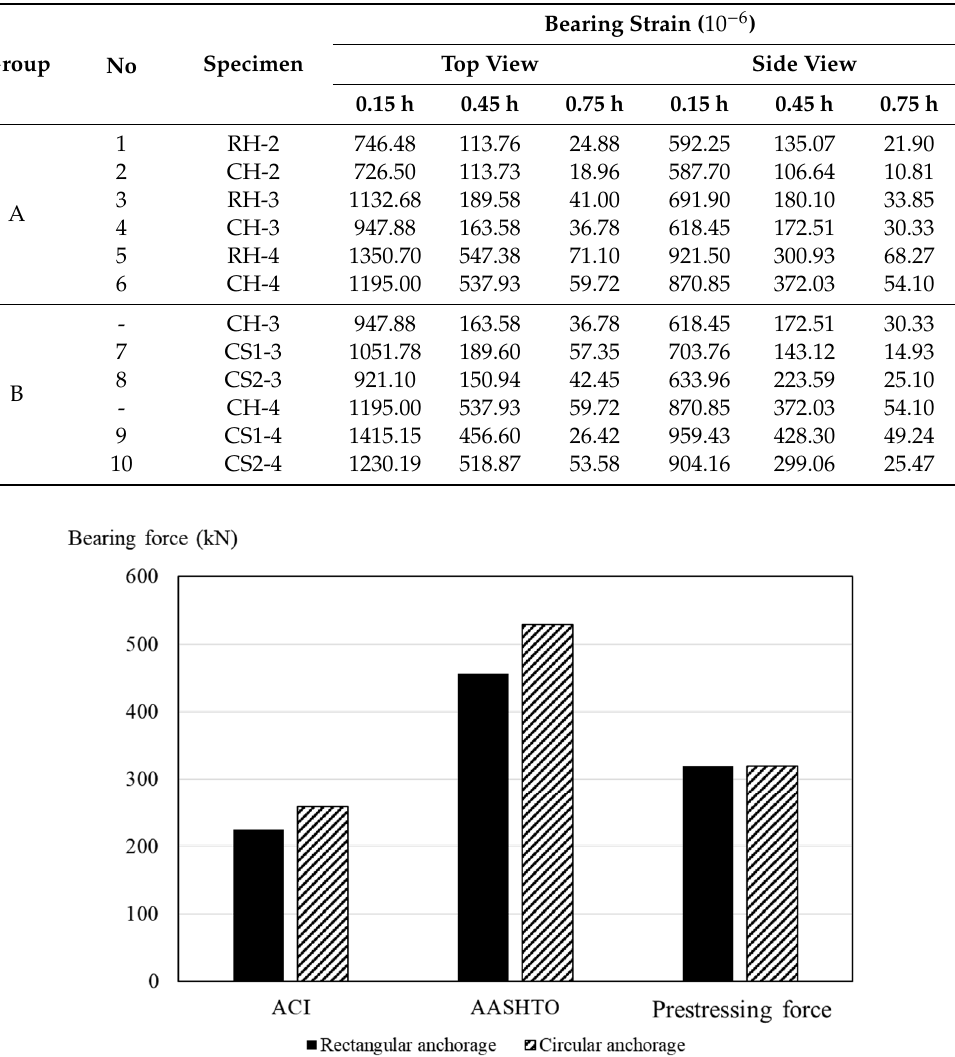
Figure 10. Comparisons of bearing force to design code.